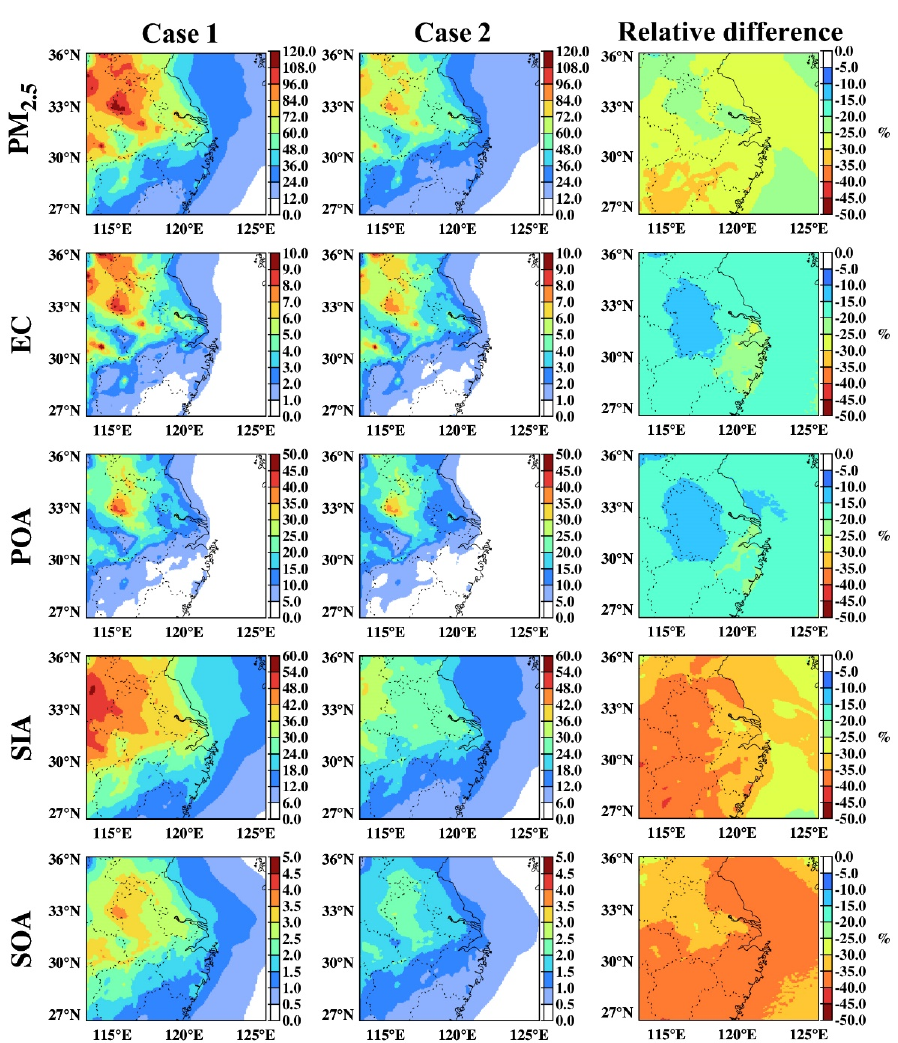
Figure 2. Spatial distribution of predicted PM 2 . 5 total and major components and changes caused by the lockdown measures in the YRD from 23 January to 28 February 2020. EC is elemental carbon, and POA is primary organic aerosol. The relative difference is calculated as (case 2 − case 1) / case 1, using the concentration. Note that the color ranges are different among